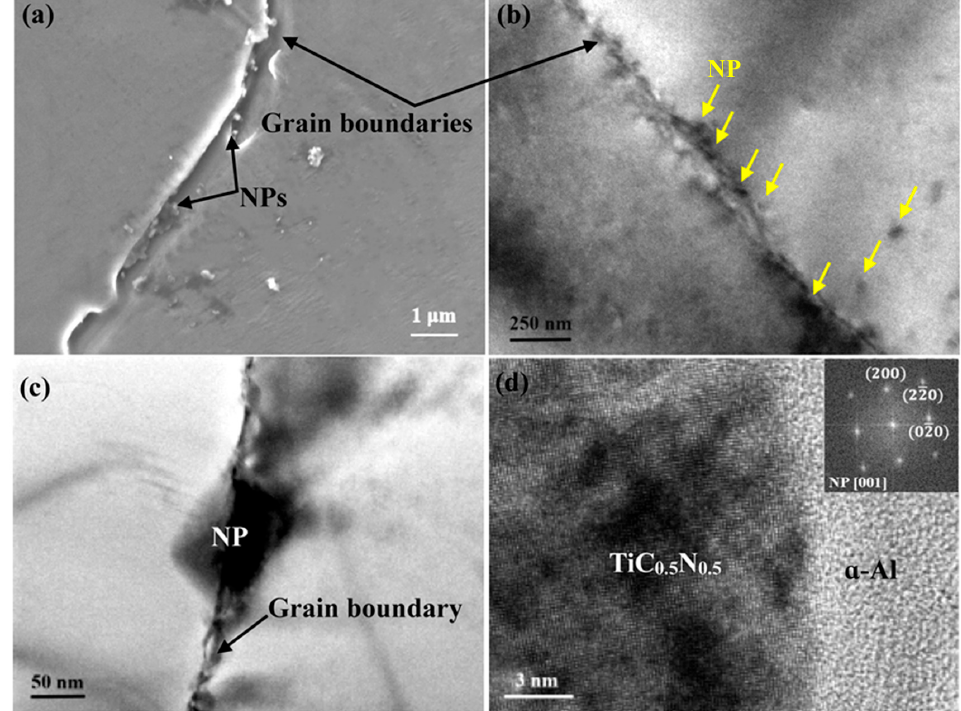
Figure 4. ( a ) SEM micrograph of CP Al with 2.0 vol.% NP addition solidified at the cooling rate of 10 K/s; ( b , c ) TEM bright field images showing the NP distribution along the grain boundary; ( d ) HRTEM image of the Al/TiC 0.5 N 0.5 interface. The inset in ( d ) is the fast Fourier transformation (FFT) of the TiC 0.5 N 0.5 nanoparticle.